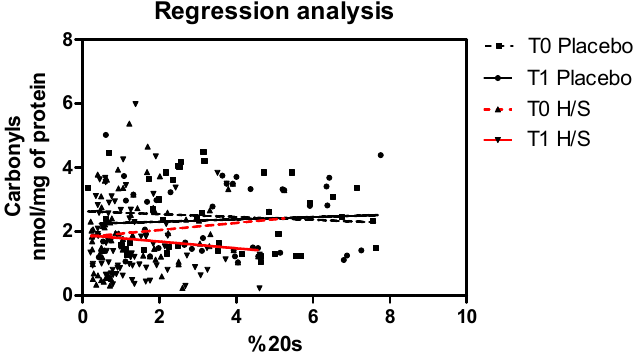
Figure 4. 20S proteasome levels and levels of oxidized proteins: Regression analysis of measured biomarkers, as assessed in the placebo subgroup and the subgroup that received the composition (H/S), before (T0) and after (T1) the intervention. 20S proteasome levels were tested in PBMCs isolated from whole blood, and oxidized proteins were tested in isolated plasma.